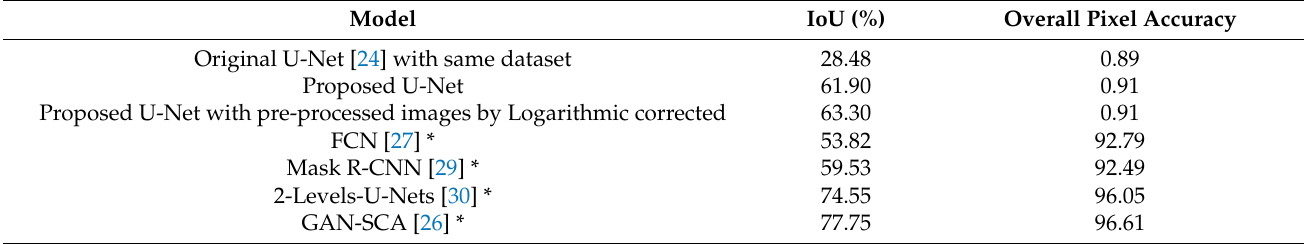
Table 6. Accuracy comparison of the proposed U-Net model with the different state-of-the-art DL architectures.